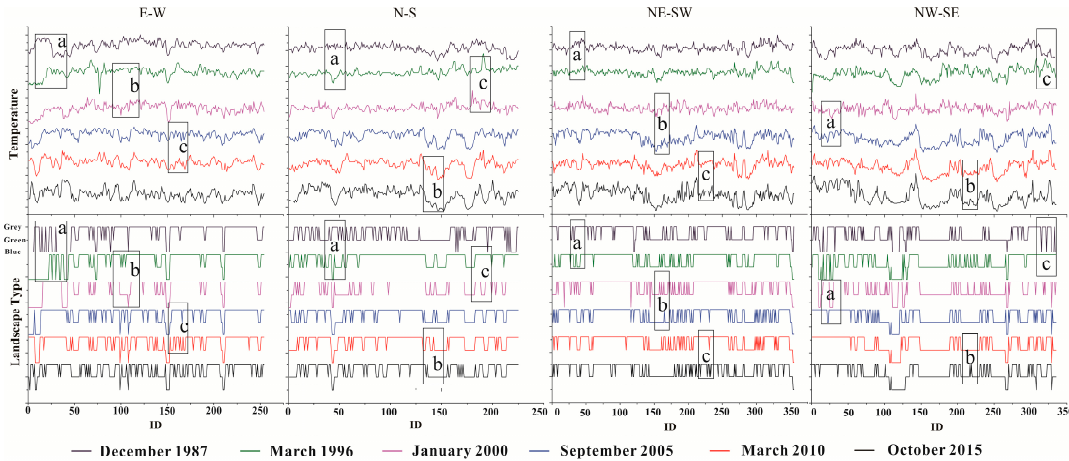
Figure 7. Correspondence of land surface temperature and landscape type in transects: east-west (EW), north-south (NS), northeast-southwest (NE-SW), and northwest-southeast (NW-SE). Windows a , b , and c highlighted specific landscape-temperature changes.